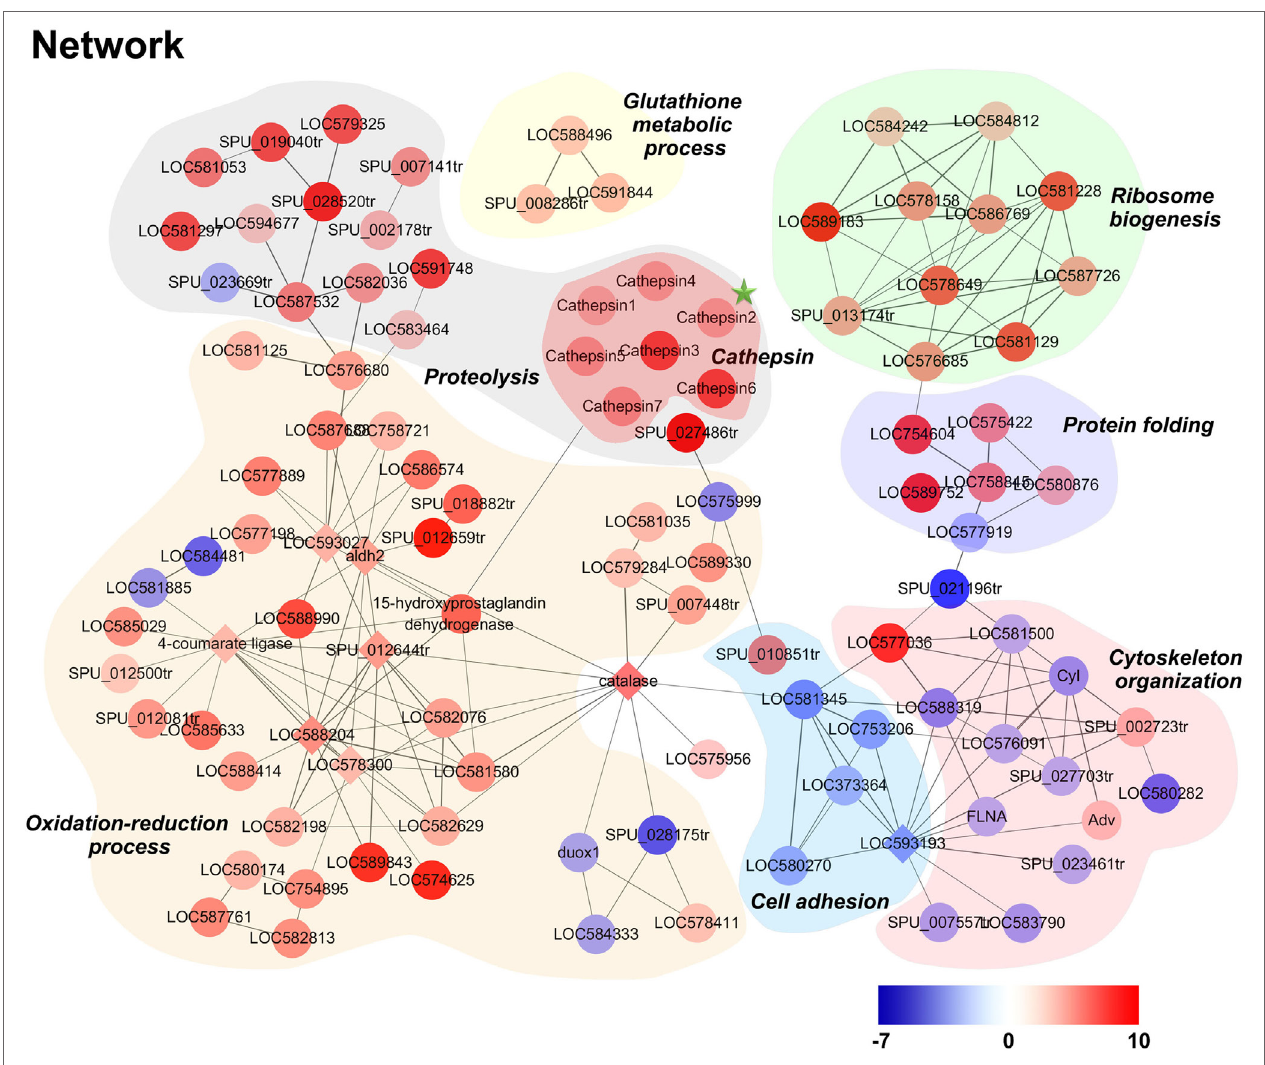
FigUre 6 | Modulation network of differentially expressed proteins (DEPs) in phagocytes. DEPs were analyzed using the software STRING and imported into Cytoscape for manual curation and grouping. The node colors on this figure correspond to absolute maximum log 2 ratio-of-ratios; significant increases and decreases in phagocyte DEPs are highlighted in red and blue,